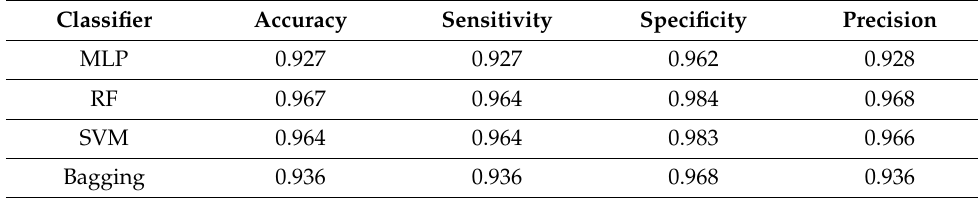
Table 4. Metric values of the model performance measure.